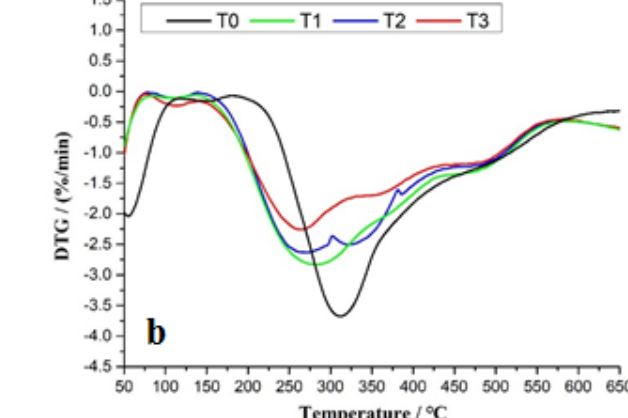
Figure 3. TG curves ( a ) and DTG ( b ) of T0, T1, T2, and T3 resins in the 50–650 ◦ C temperature range.